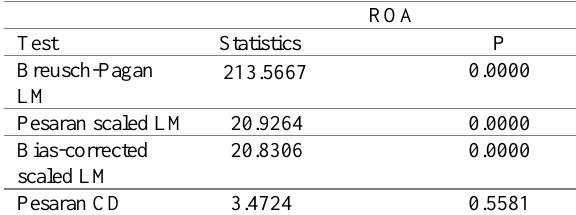
Table 7. Cross-sectional dependence test results of Model 2